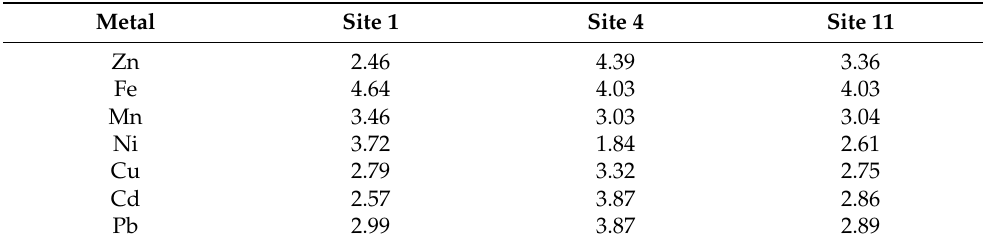
Table A2. Partition coefficients (log K d ) in bottom sediment and water at particular sites (in July